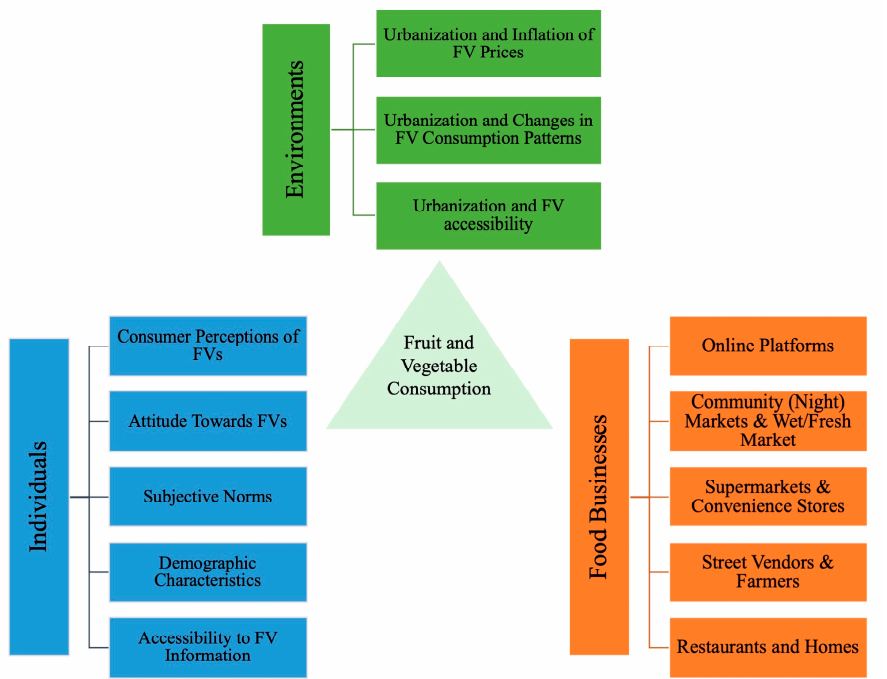
Figure 4. The interactions of FV consumption in three perspectives: individuals, food businesses and